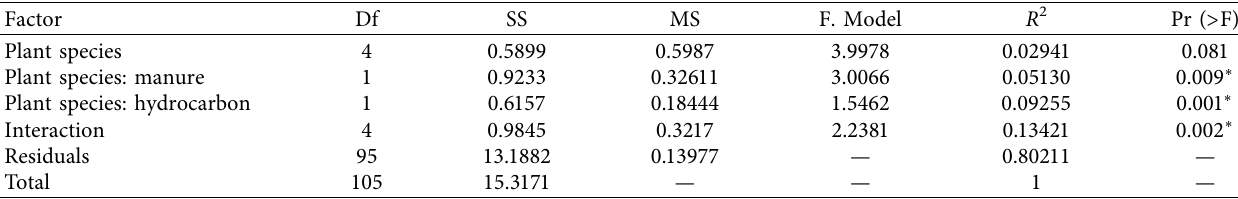
Figure 1: Rarefaction curve showing sampling depths across the five plant species with and without compost and petroleum contamination (T1 � plant species only, T2 � plant species and hydrocarbon, T3 � plant species and Manure, and T4 � plant species, manure, and hydrocarbon). Table 1: PERMANOVA analysis of interaction effects of plant species, organic manure, and hydrocarbons on bacterial community based on Bray–Curtis